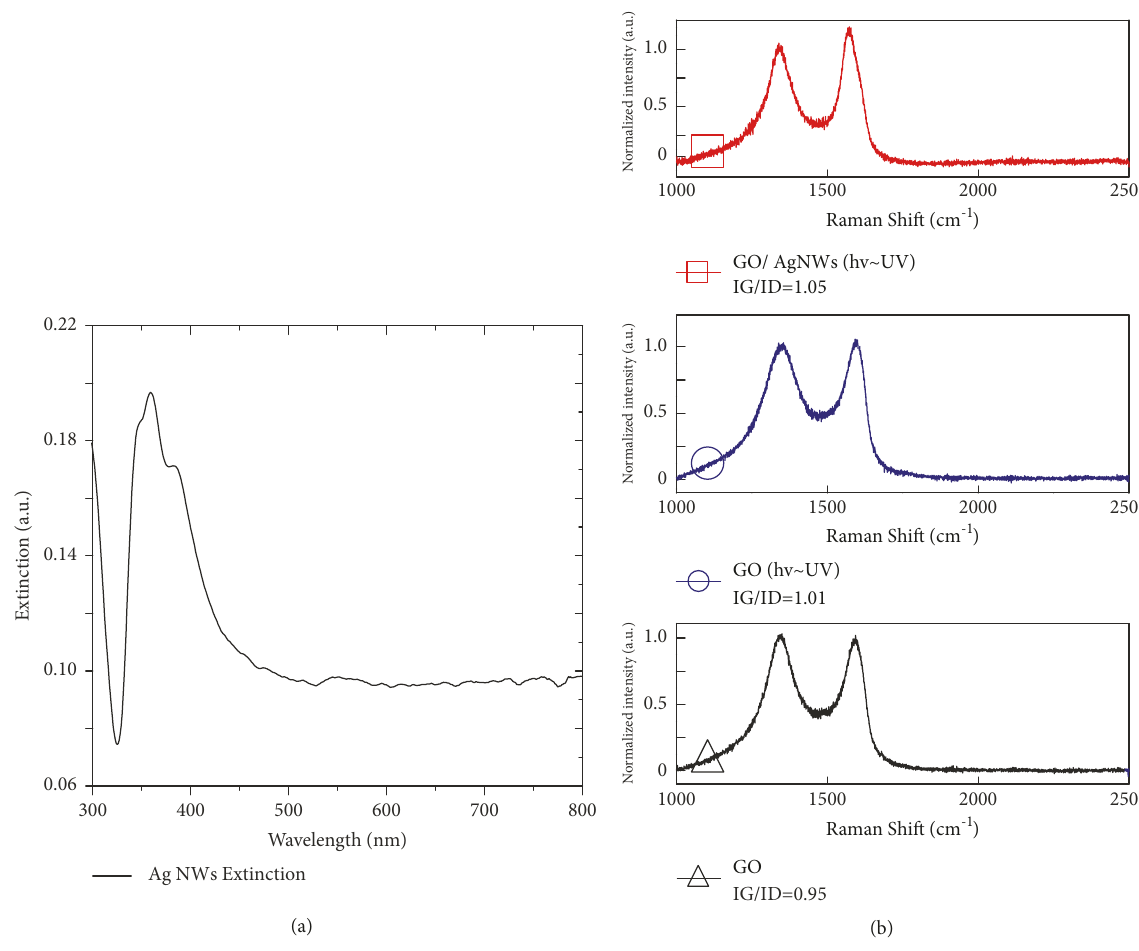
Figure6:(a)ExtinctionspectrumofAgNWsand(b)normalizedRamanspectraofGO,GOafterUVirradiation,andGOafterUVirradiation with Ag NW